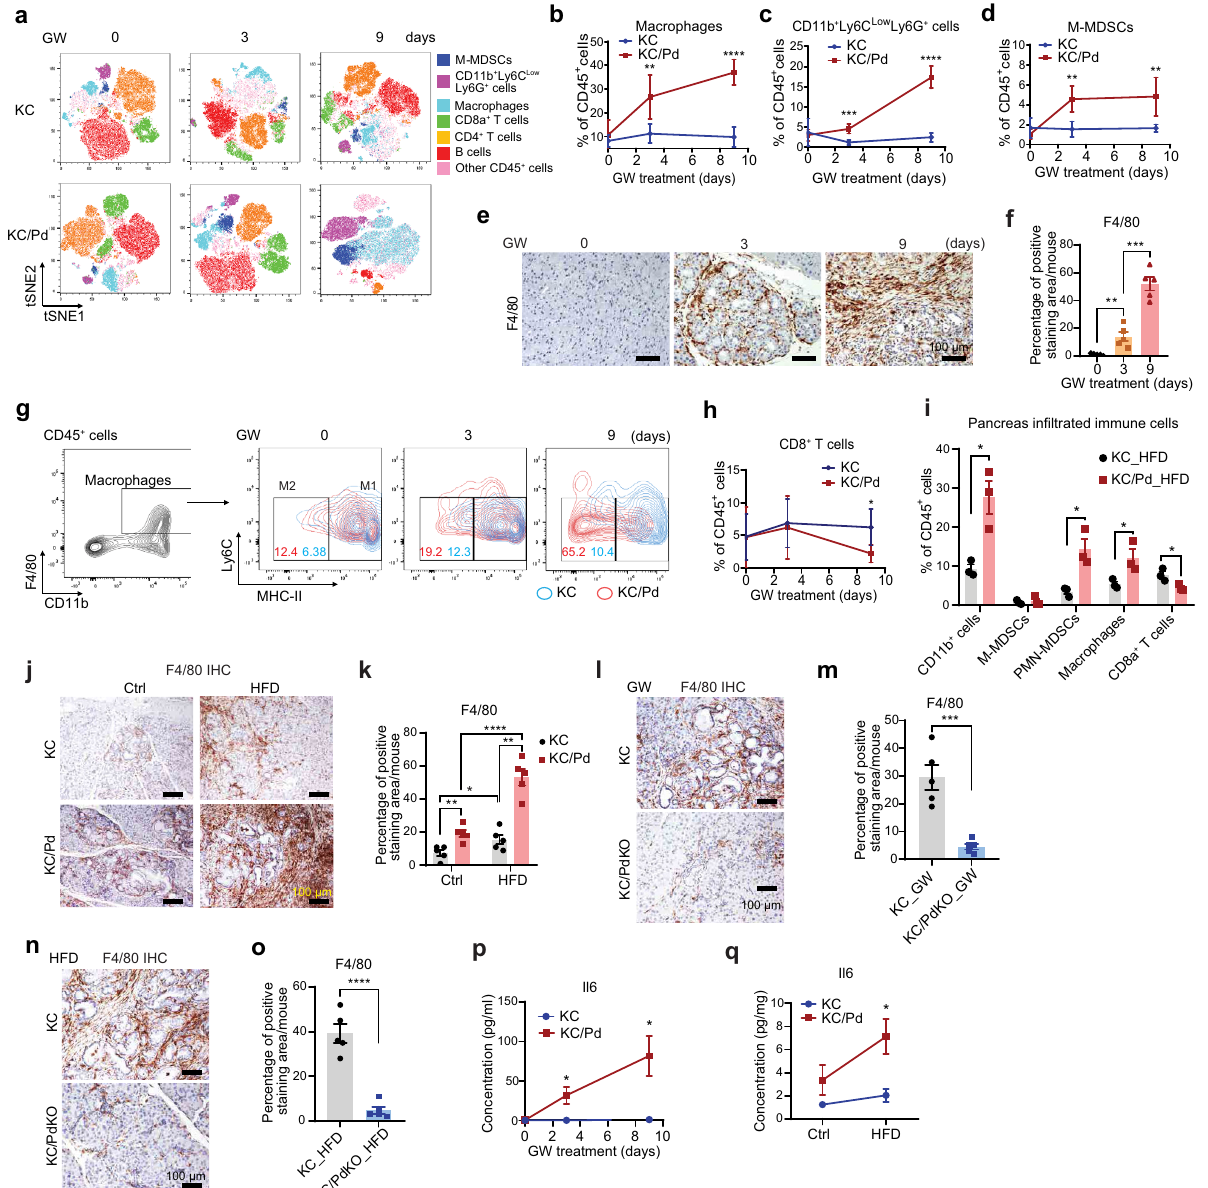
Fig. 5 PPAR δ activation by GW or HFD recruits macrophages and MDSCs into the pancreata to remodel pancreatic TME. a Representative immune cell pro fi ling by FlowJo-tSNE (t-distributed stochastic neighbor embedding) of pancreas-in fi ltrating CD45 + cells, including M-MDSCs (CD11b + Ly6C hi Ly6G − ), CD11b + Ly6C low Ly6G + [polymorphonuclear (PMN)-MDSCs and neutrophil cells]), macrophages (CD11b + F4/80 + ), CD3 + CD4 + cells, CD3 + CD8 + T